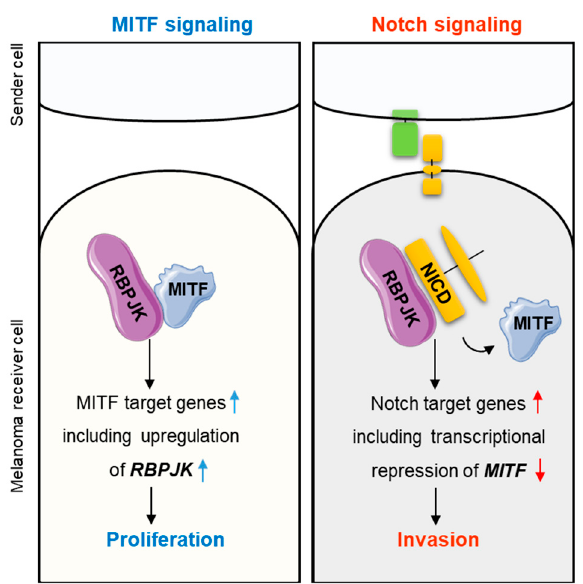
Figure 3. Two modes of regulation are involved in the crosstalk between the Notch and MITF pathways in melanoma. Competition-based regulation: In the absence of cells that express the Notch ligand in the melanoma microenvironment, RBPJK directly binds to MITF and enhances MITF-mediated transcriptional upregulation of its target genes. Upon activation of Notch signaling, NICD competes with MITF for binding to RBPJK, leading to the removal of the RBPJK-MITF complex from MITF’s target promoters (Golan 2015). Transcription-based regulation: MITF binds to the RBPJK promoter and positively regulates its expression. Notch signaling activation inhibits the transcription of the MITF gene and thus decreases MITF levels, resulting in an invasive and metastatic phenotype. Blue arrow represents MITF target genes; Red arrow represents Notch signaling target genes; Green Shape represents DLL1; Yellow shape represents Notch receptor (intact or cleaved). Blue letters represent induction of MITF signaling and the proliferative phenotype; Red letters represent induction of Notch signaling and the invasion phenotype. 3. Materials and Methods.